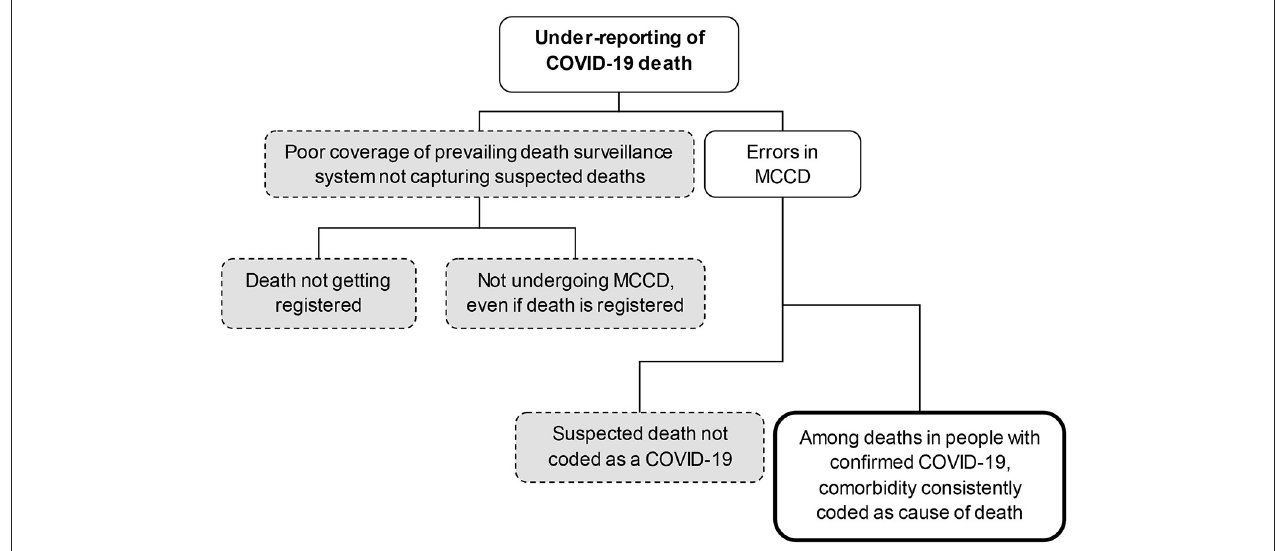
FIGURE 1 | The levels/causes of under-reporting of COVID-19 deaths*. MCCD, medical certification of cause of death. *Dotted and shaded boxes related to the under-reporting of COVID-19 deaths among non-reported cases, Bold and non-shaded box related to under-reporting among confirmed cases.